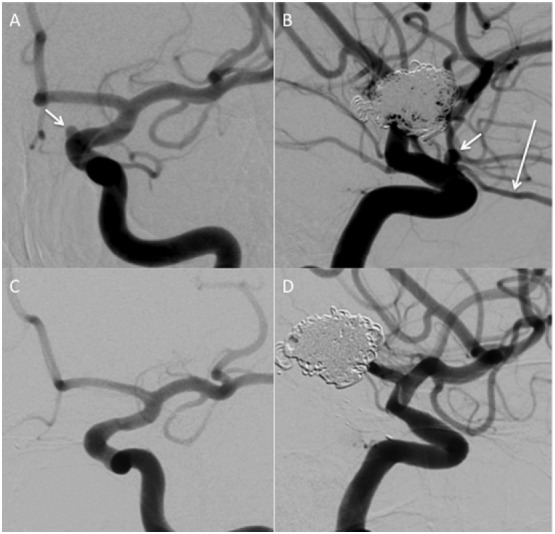
A 3 mm aneurysm arising from the para-ophthalmic segment on the left [(A,B), short white arrows]. Normal filling of the ophthalmic artery is seen [(B) long white arrow]. On delayed angiography (C,D) the aneurysm is excluded from the circulation and there is no anterograde filling of the ophthalmic artery. The patient did not report any new visual symptoms.